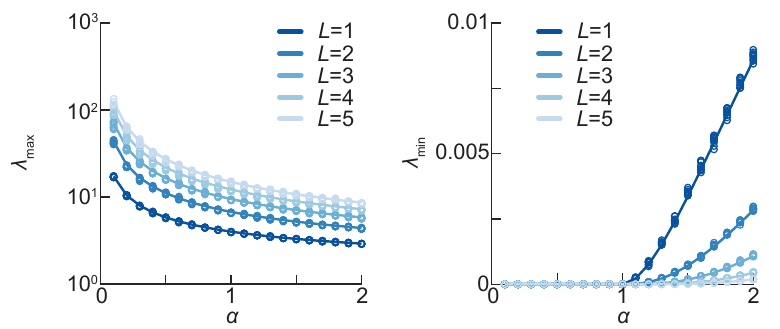
Figure 4: Maximum ( left ) and minimum ( right ) eigenvalues of Wishart product ma- trices for varying depths L (with higher values indicated by lighter shades of blue) = α = ··· = α = α . In each panel, the theoretical predic- and varying widths α L 1 2 tions from equations (50) and (52), respectively, are plotted as solid lines, while the open circles show the results of numerical eigendecompositions for 10 realizations = of matrices of size n 0